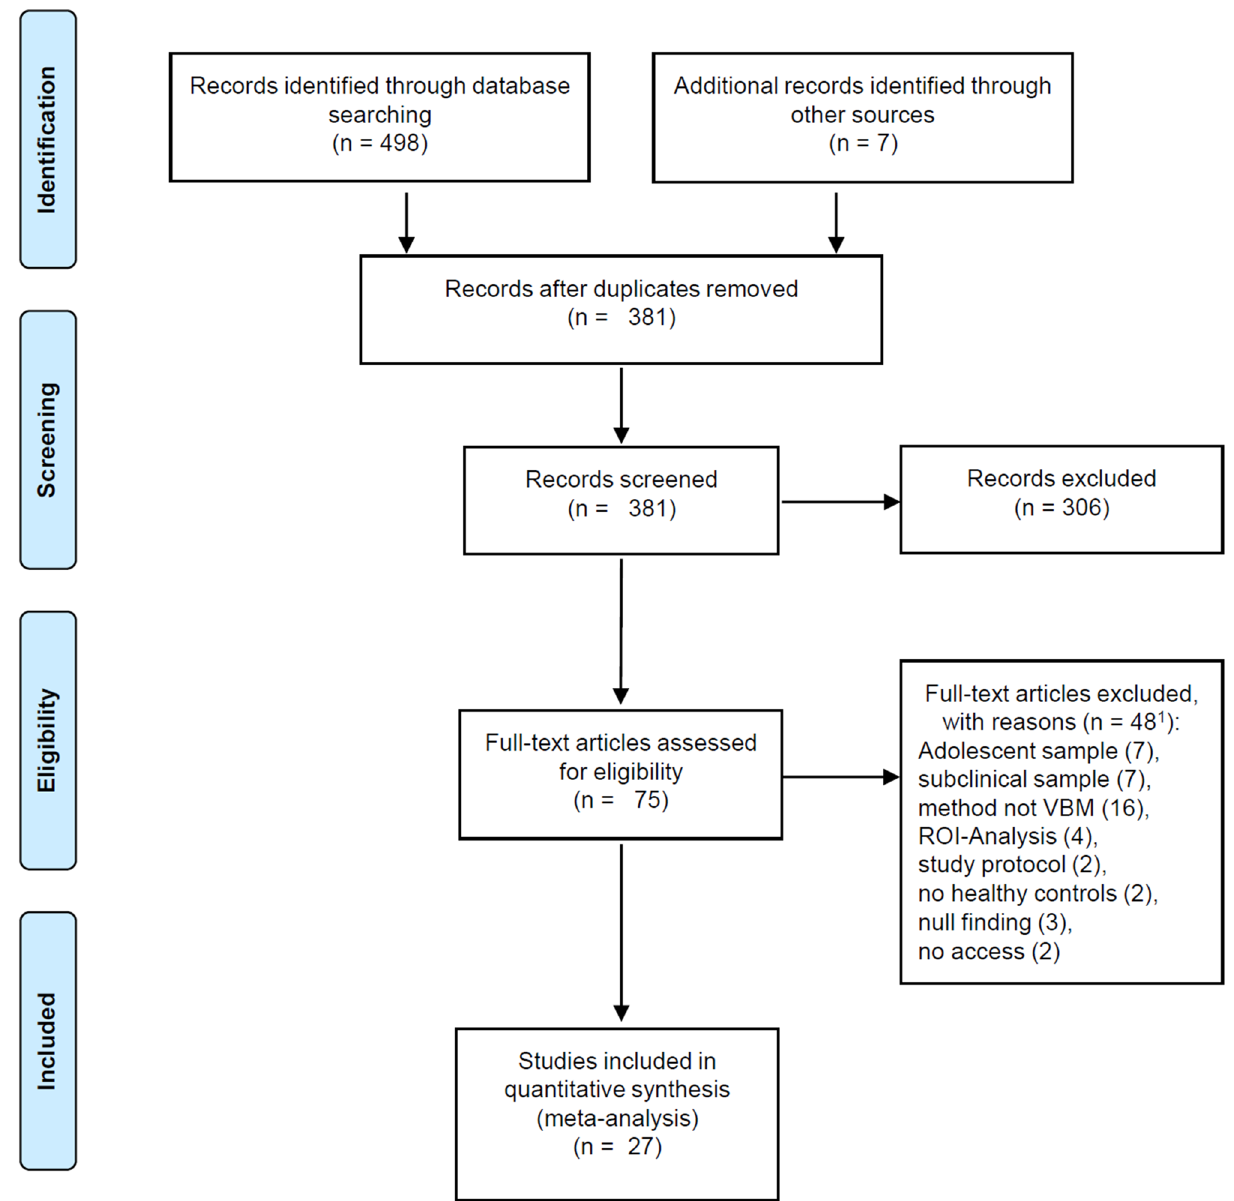
excluded articles and exclusion reasons result from studies excluded because of multiple exclusion